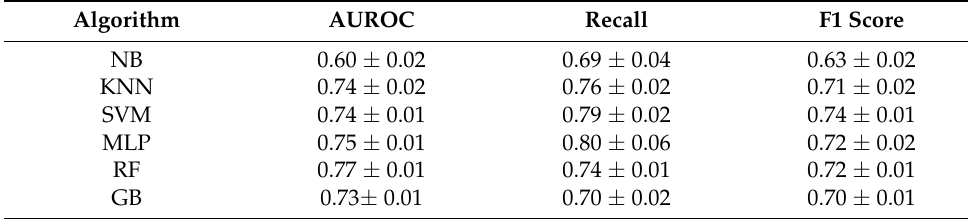
Table 5. Predictive performance of machine learning classifiers on modified-dataset.